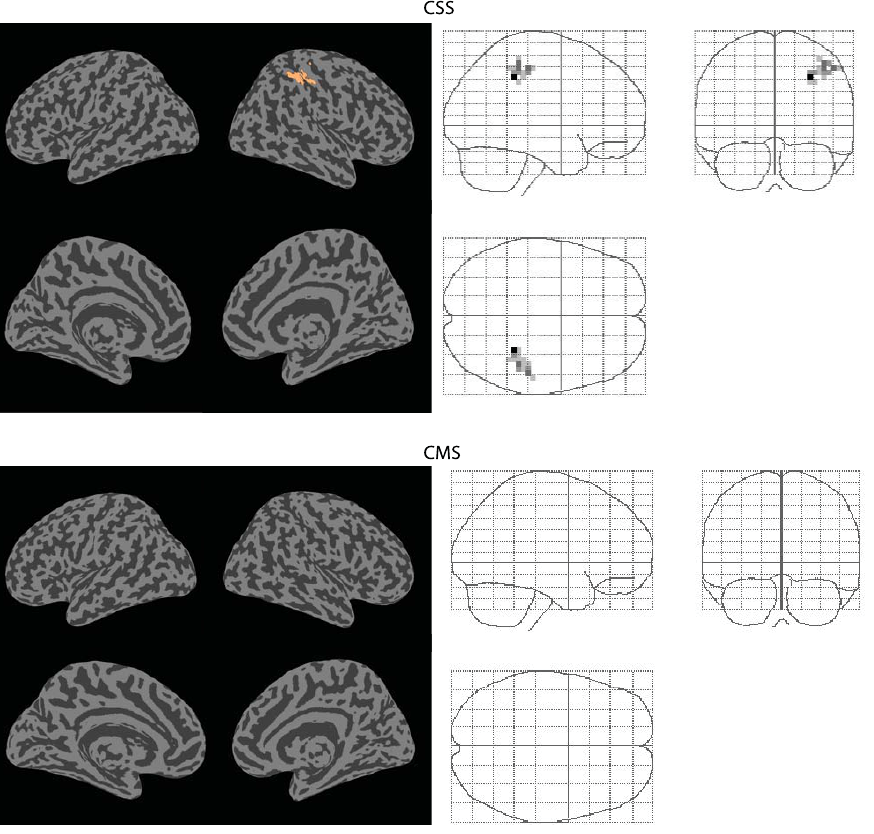
Figure 7. Connectivity decreases. Significant decreases (p , 0.05 FWE corrected) in functional connectivity between normocapnia and hypercapnia, identified by the CSS and CMS